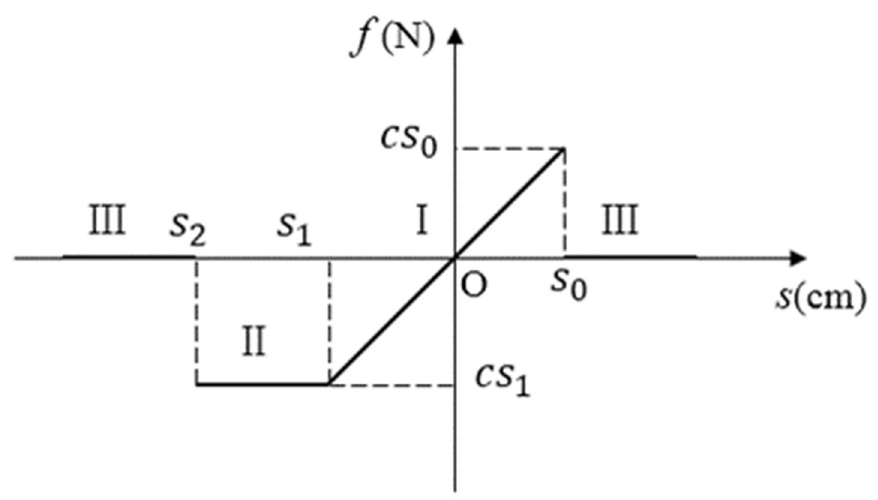
Figure 8. Constitutive model of asphalt mixture.